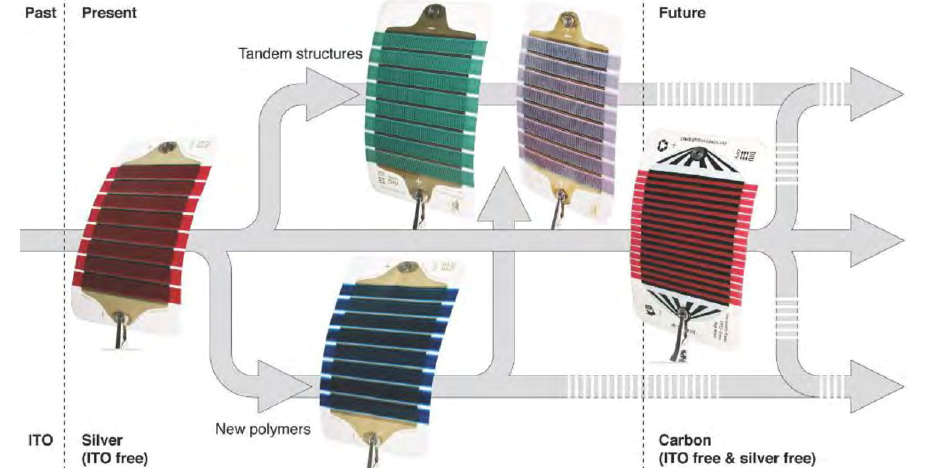
Figure 6 . An illustration of the evolution of the freeOPV platform from its initial form based on slanted silver grids and poly(3-hexylthiophene):phenyl-C61-butyric acid methyl ester (P3HT:PCBM) as the active materials to encompass novel polymer active materials and present complex multilayer architectures such as the tandem freeOPV. Printed carbon electrodes for consumer electronics with low environmental impact are demonstrated [44]. (Reproduced from Ref. [44], 10.1002/aenm.201400732, with permission.)